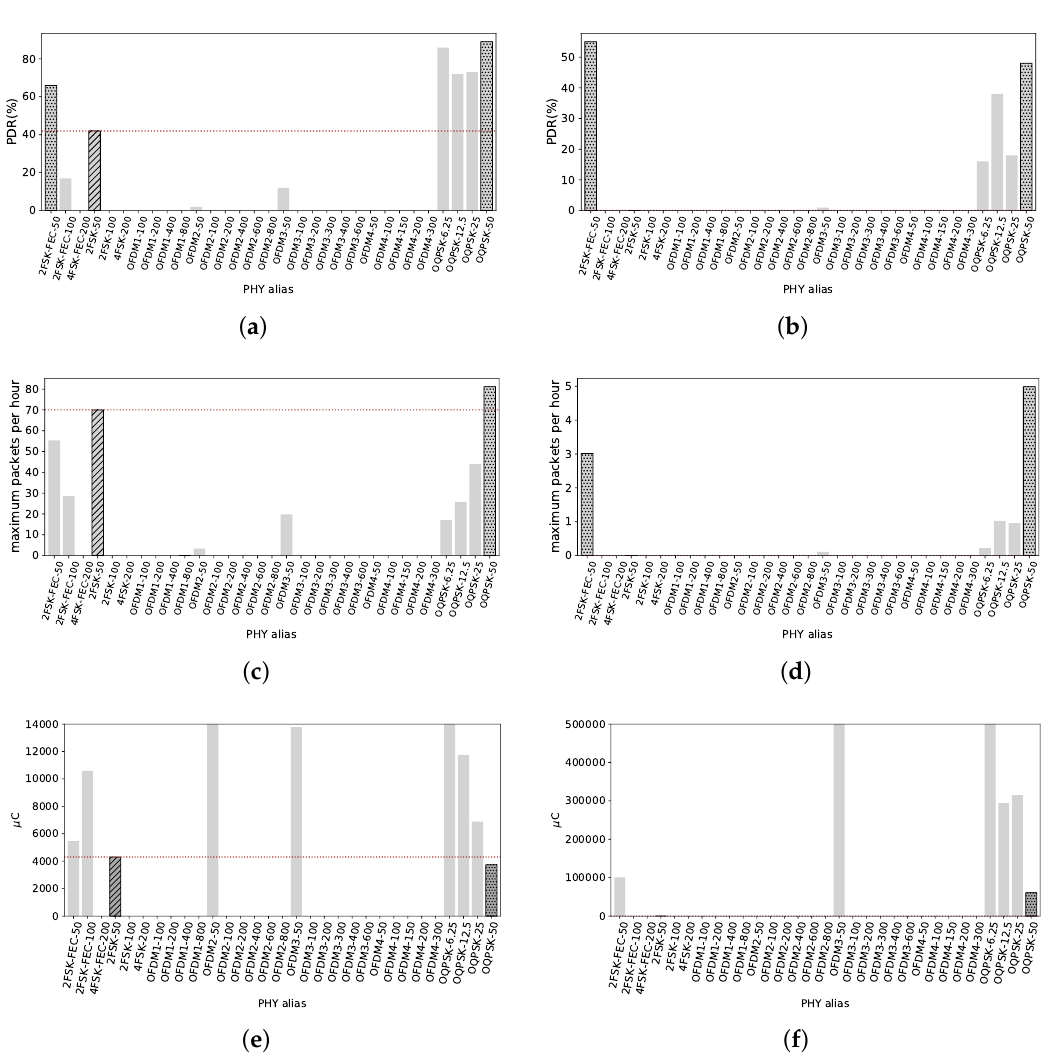
Figure 12. Urban Canyon, 779 m. The limit of the radio link is very close to this distance of 779 m from the TX node. The PDR for short and long packets is poor, so is the maximum amount of packets per hour. Applications with short packets and low throughput can stand radio links with similar characteristics. ( a ) PDR with packets of 127 B. Only data rates up to 50 kbps provide some connectivity, with the exception of O-QPSK-50 whose PDR is above 80%. We are very close to the maximum length of the radio link. PDR of 2FSK-50 is 42%; ( b ) PDR with packets of 2047 B. Only 2FSK-FEC-50 has a PDR over 50%. The rest of the radio settings does not provide any connectivity, with the exception of the O-QPSK radio settings; ( c ) Maximum amount of short packets transmitted per hour. The reference 2FSK-50 can send up to 70 packets and OQPSK-50 81 packets; ( d ) Maximum amount of long packets transmitted per hour. OQPSK-50 can send up to 5 2047 B packets per hour under the 0.1% duty cycle regulation; ( e ) Average electric charge consumption per 127 B packet sent. 2FSK-50 needs 4.3 mC to transmit one short packet whilst OQPSK-50 consumes 3.7 mC per packet; ( f ) Average electric charge consumption per packet of 2047 B sent. O-QSPK consumes 60.7 mC, less than any other radio